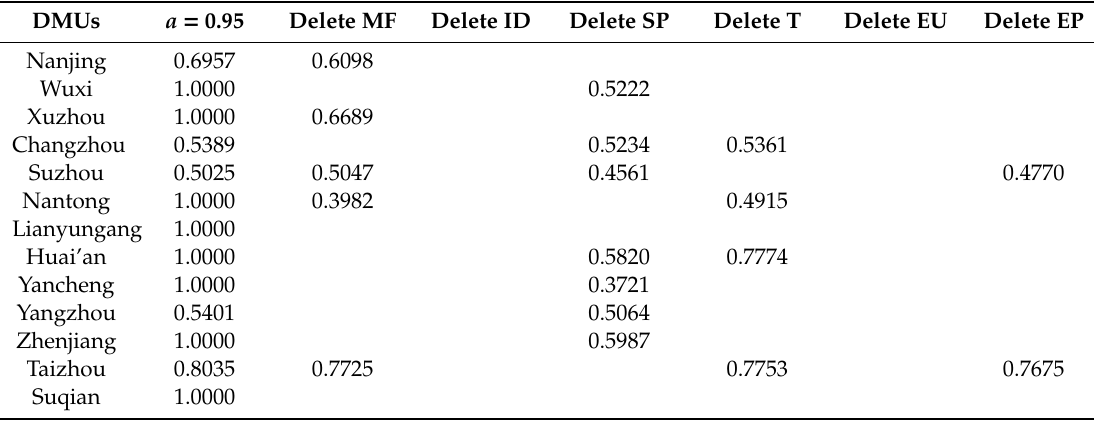
Table A2. The changes of stochastic e ffi ciency value by deleting grouping input variables in 2014 ( α =